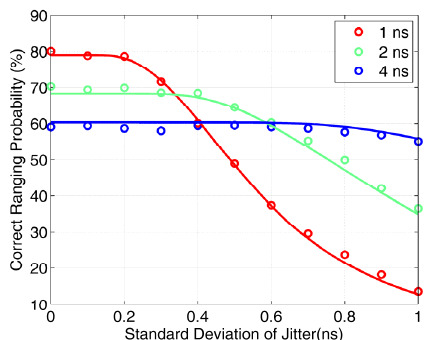
Figure 8. The influence of jitter on correct ranging probability under different pulse widths.